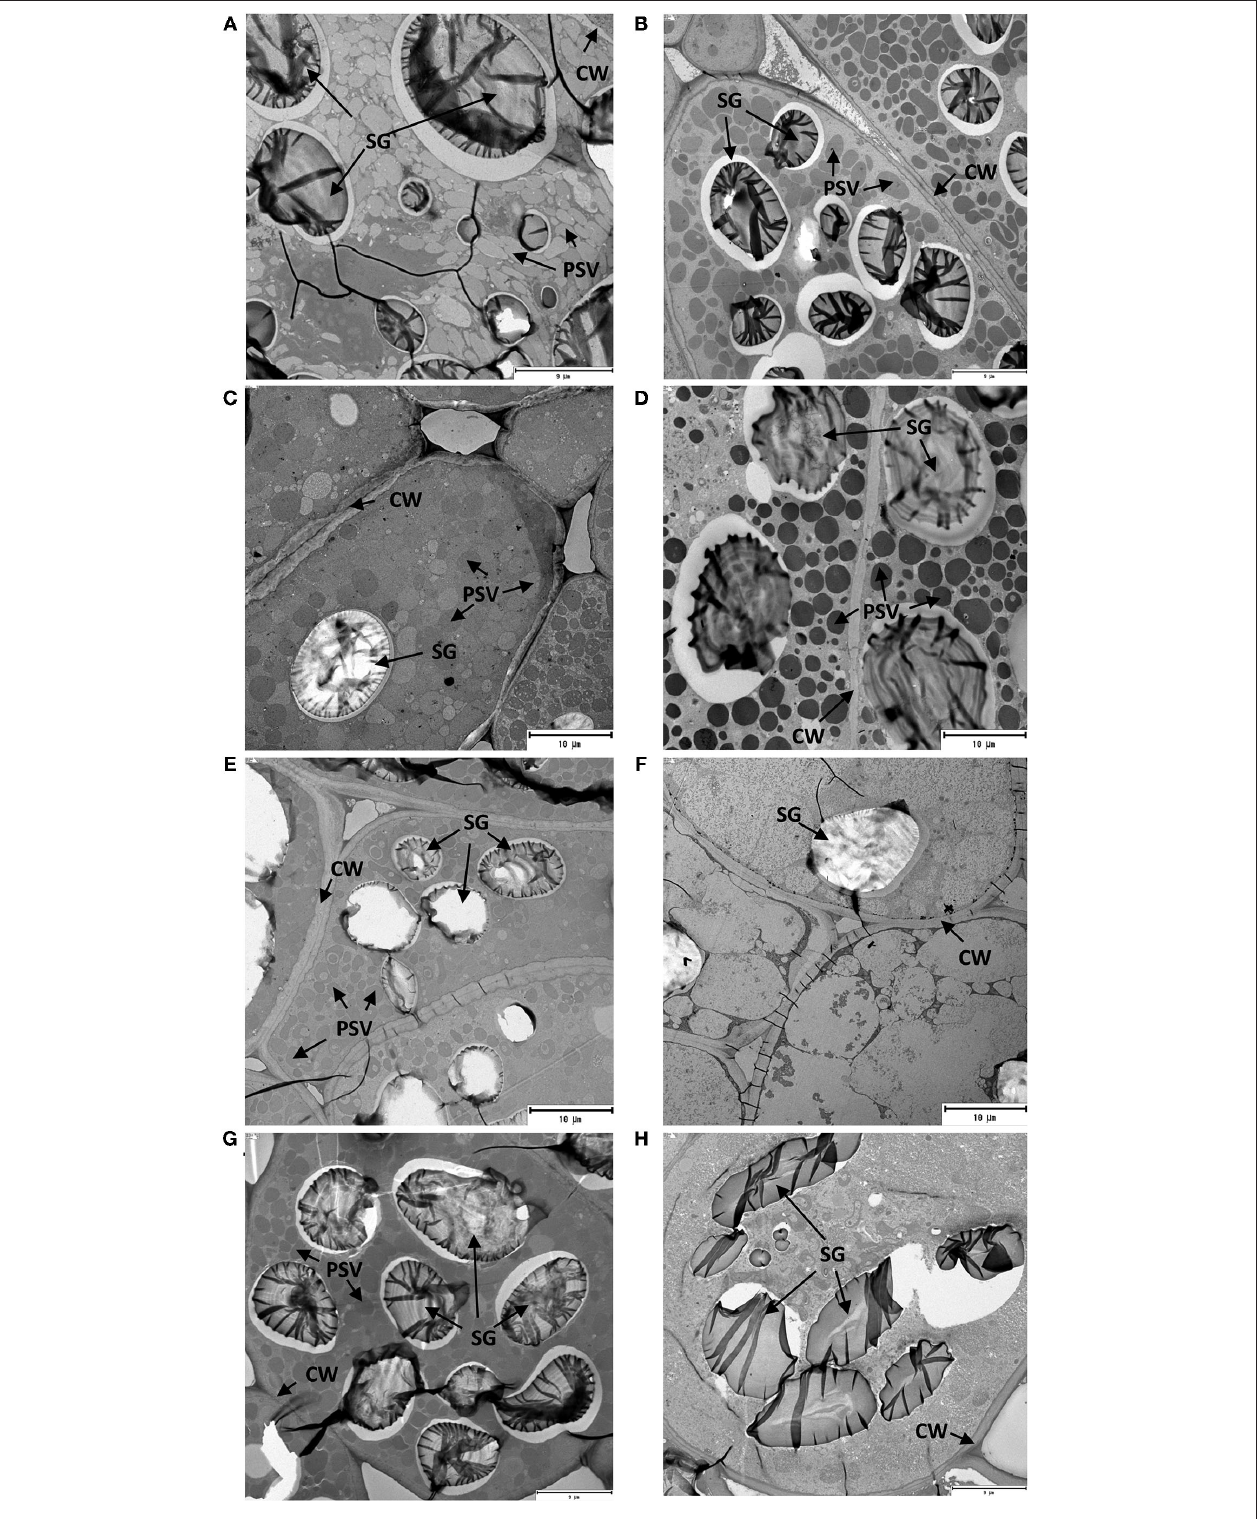
FIGURE 2 | Transmission electron micrographs of cotyledons from the soaked ( A,C,E,G corresponding to GZL, BL, DL, and ZF, respectively) and sprouted lentil and fava bean seeds at 20 ◦ C for 96h ( B,D,F,H corresponding to GZL, BL, DL, and ZF, respectively).